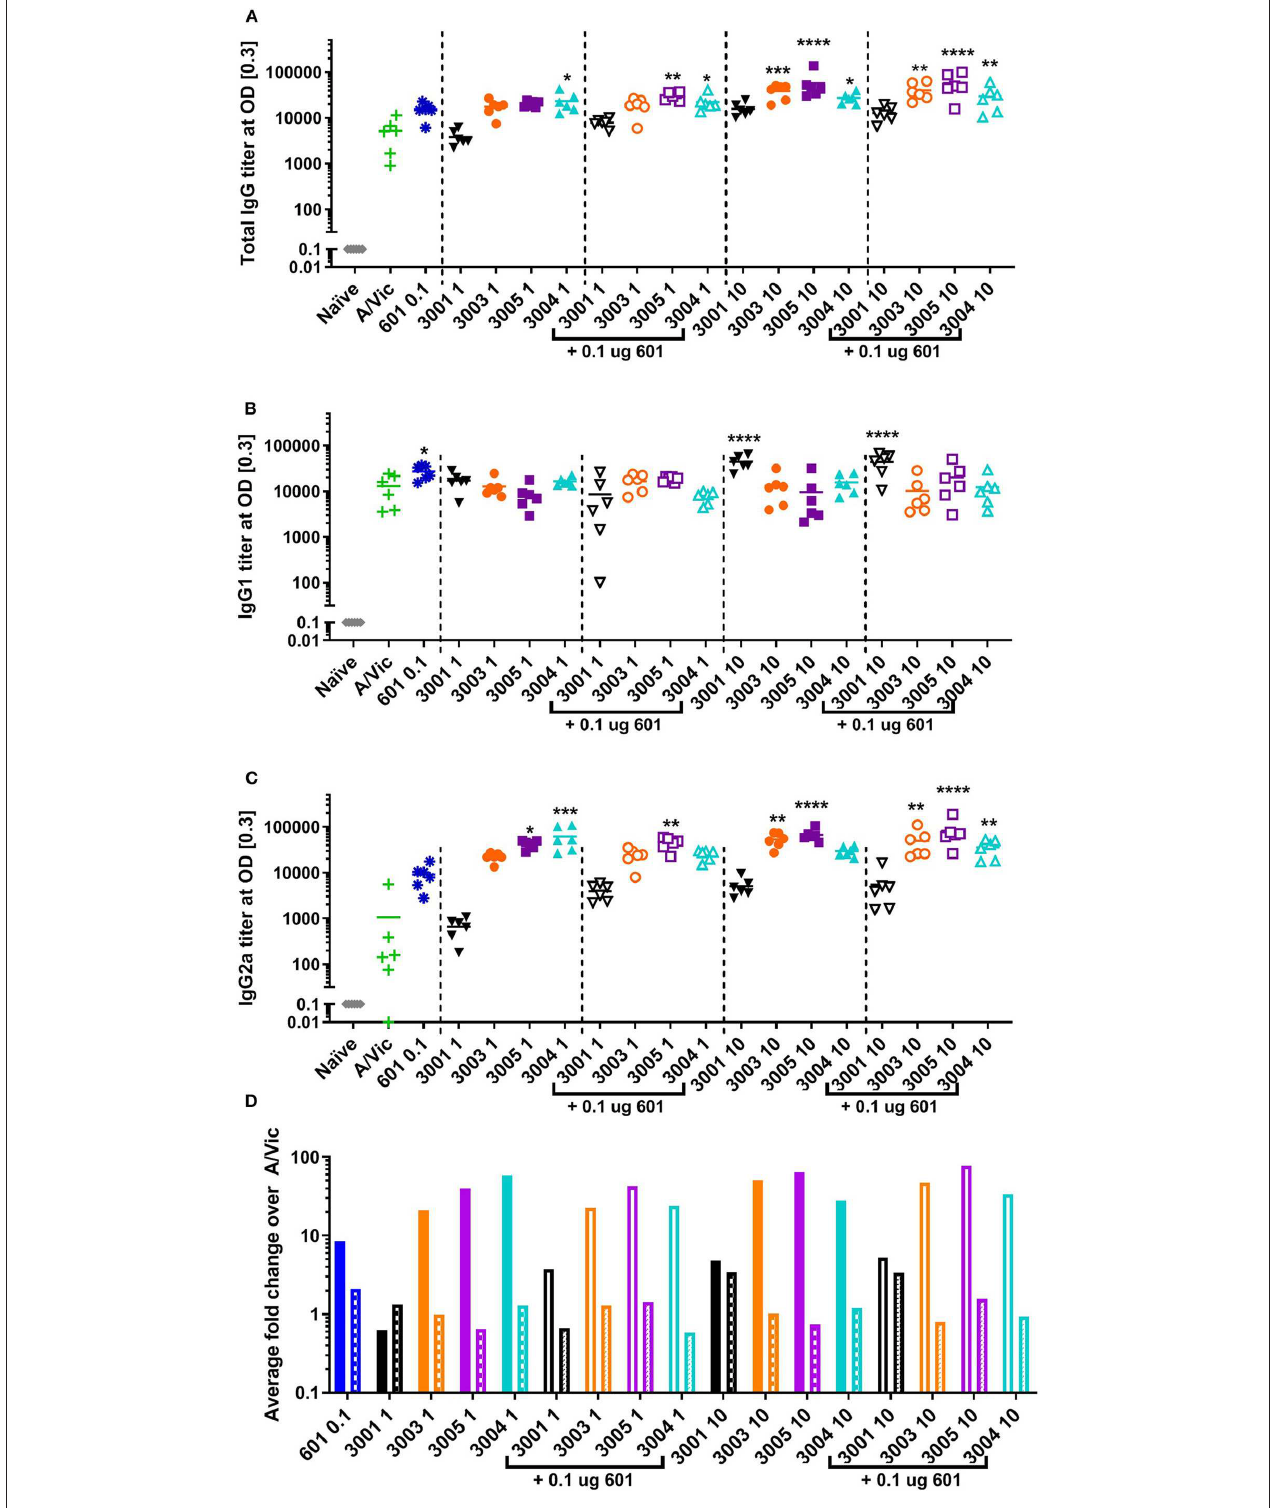
FIGURE 2 | Lipidated imidazoquinolines elicit an IgG2a-biased influenza-specific antibody response after a single intramuscular vaccination. Balb/c mice (6 per group) were injected once i.m. with 0.3 µ g/mouse A/Vic monovalent detergent-split influenza vaccine adjuvanted with indicated TLR4 (0.1 µ g), TLR7/8 (1 or 10 µ g as